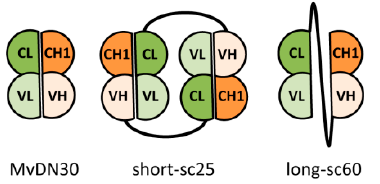
Figure 7. Schematic representation of the hypothesized structure of DN30-derived molecules. VL: variable light domain derived from DN30; CL: constant light domain derived from human IgK light chain; VH: variable heavy domain derived from DN30; CH1: first constant heavy domain derived from human IgG1 heavy chain. Black line represents the amino acid linker.